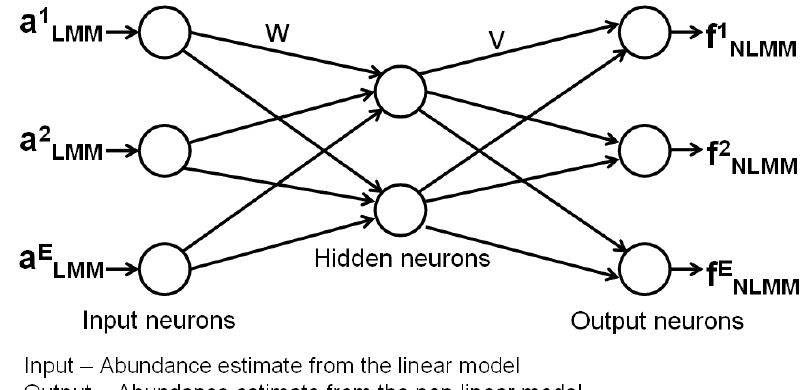
Figure 1. Architecture of the multi-layer perceptron (MLP) model.